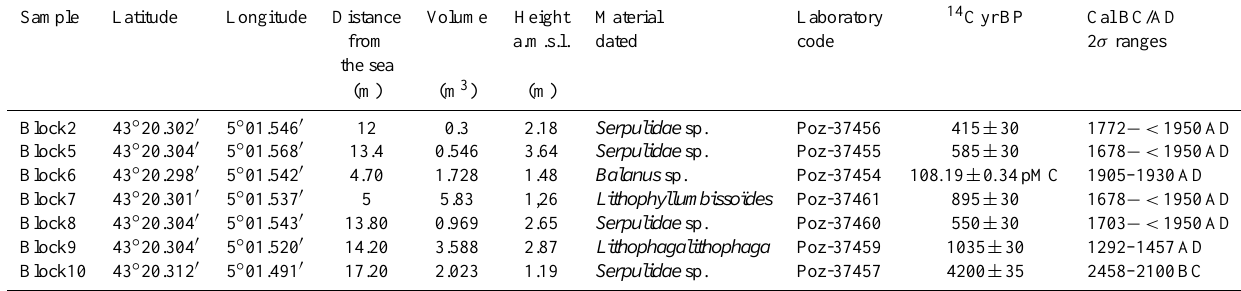
Table 2. Samples of shells collected and dated by 14 C from biogenic encrustations on boulders, showing ages calibrated using calib5 (Stuiver and Reimer, 1993; Hugen et al., 2004). Sample Latitude Longitude Distance Volume Height